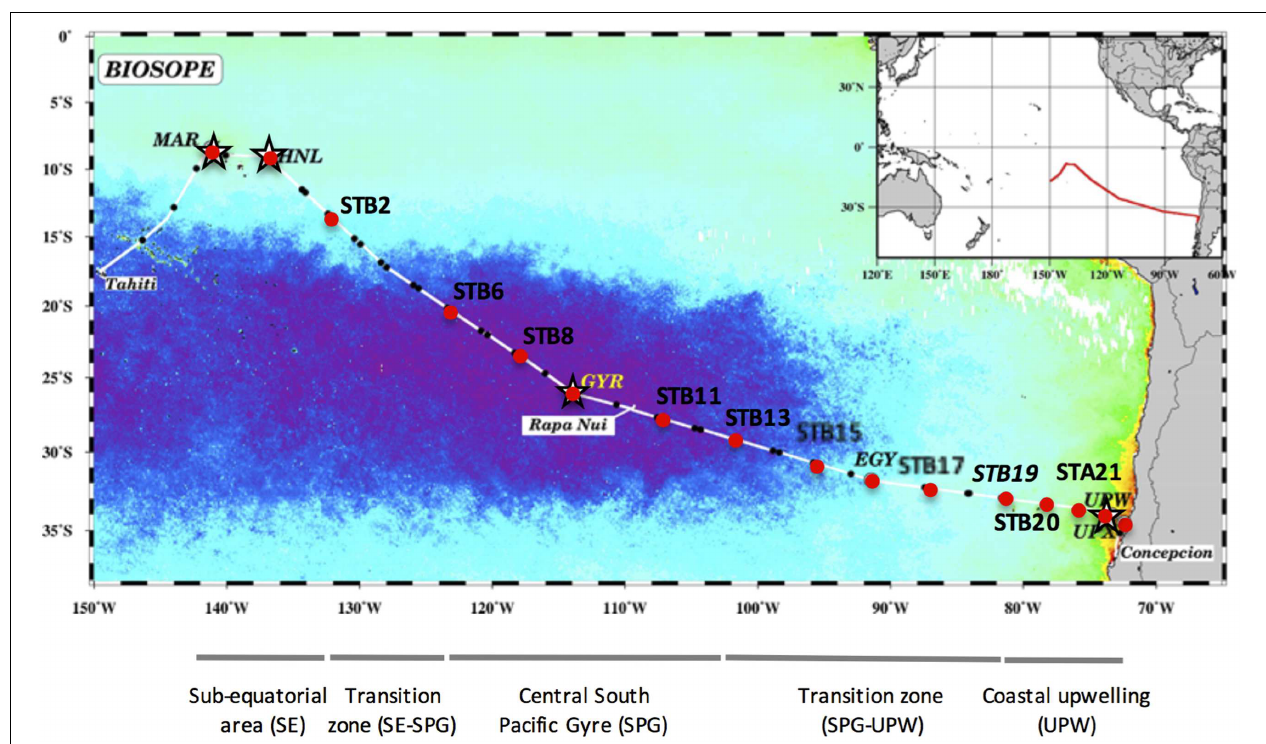
FIGURE 1 | Map of stations sampled during the BIOSOPE cruise, superimposed on a SeaWiFS composite image of Chl a concentration in the upper layer for November–December 2004. The purple area indicates the extent of the hyperoligotrophic gyre. The stations analyzed by SSCP are marked with a red dot and those used for 16S rRNA gene clone library construction are indicated with a star. The different water masses illustrated under the map are those defined previously (Claustre et al., 2008).